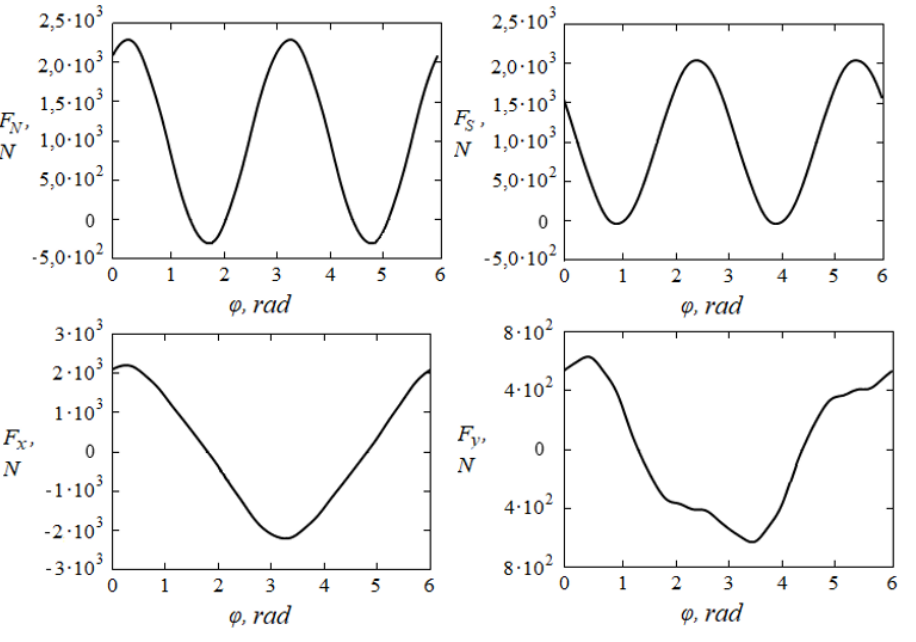
Fig. 12. Reaction